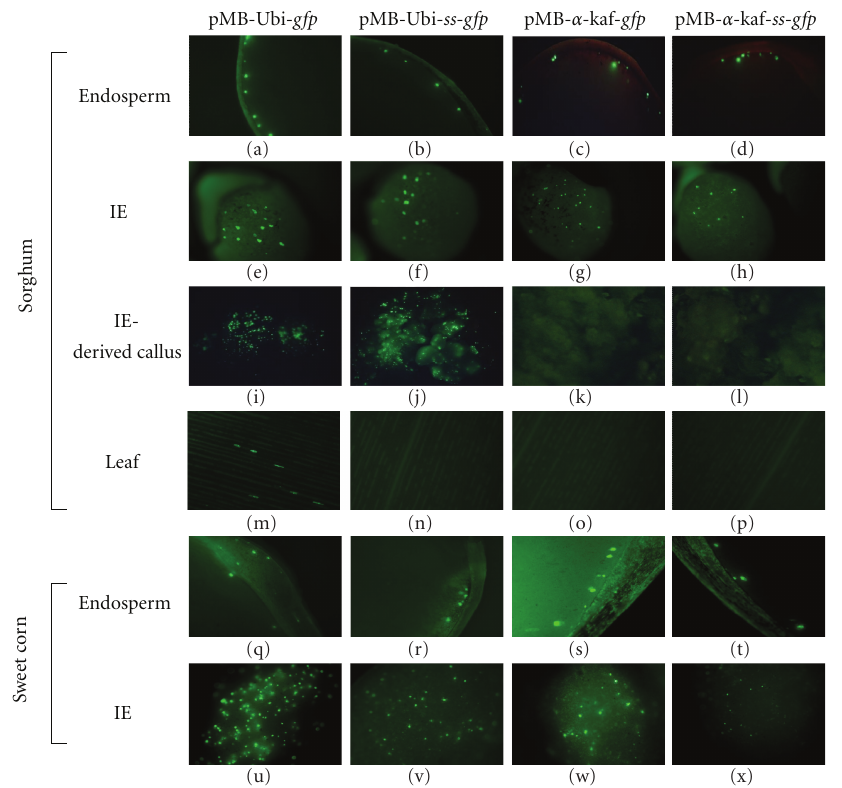
Figure 4: Sorghum explants bombarded with pMB-Ubi- gfp ((a), (e), (i), (m), (q), and (u)), pMB-Ubi- ss-gfp ((b), (f), (j), (n), (r), and (v)), pMB- α -kaf- gfp ((c), (g), (k), (o), (s), and (w)), and pMB- α -kaf- ss-gfp ((d), (h), (l), (p), (t), and (x)). The sorghum explants were endosperm ((a)–(d)), immature embryo ((e)–(h)), immature-embryo-derived callus ((i)–(l)), and leaf ((m)–(p)). The sweet corn explants were endosperm ((q)–(t)) and immature embryos ((u)–(x)).